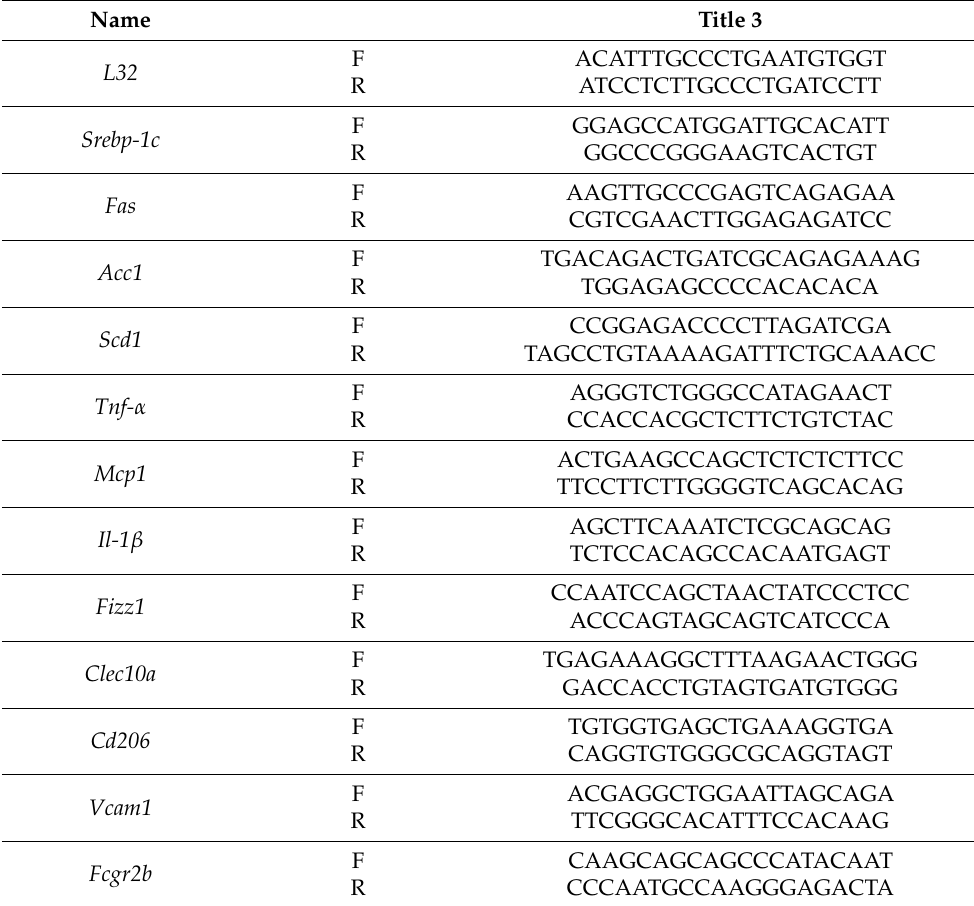
Table 1. Primer sequences of genes used in